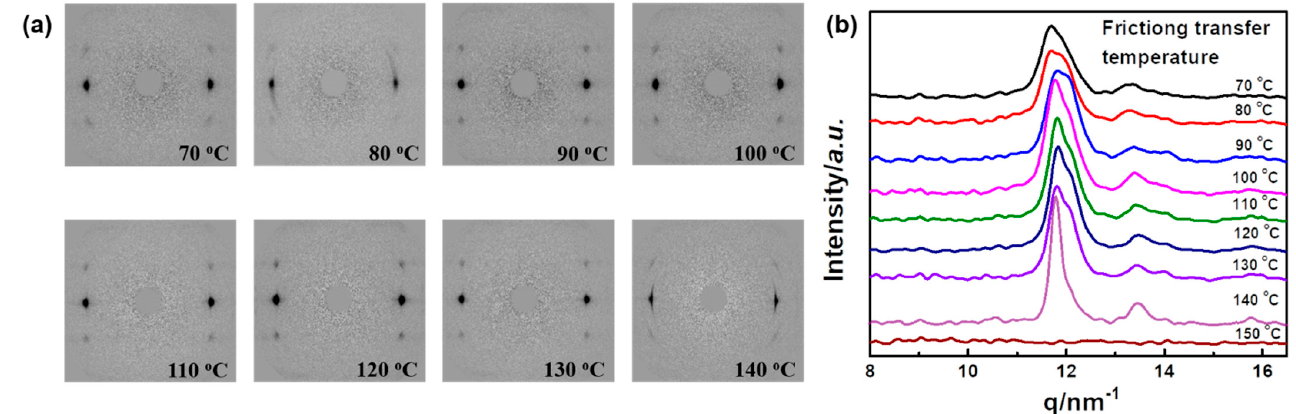
Figure 2. 2D X-ray diffraction diagrams ( a ) and corresponding 1D X-ray diffraction profiles ( b ) of friction transferred PLLA at different temperatures. The 2D WAXD patterns processed by subtracting of amorphous part.